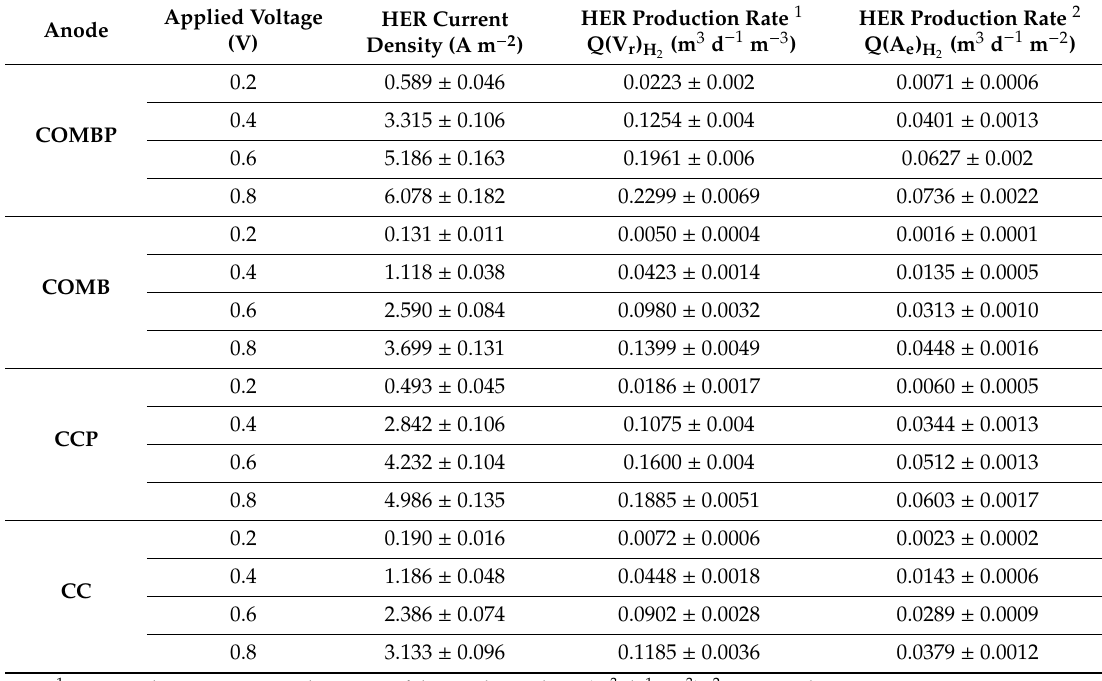
Table 2. HER measurement of MECs based on COMBP, COMB, CCP, and CC anode (Cell potentials). Applied Anode